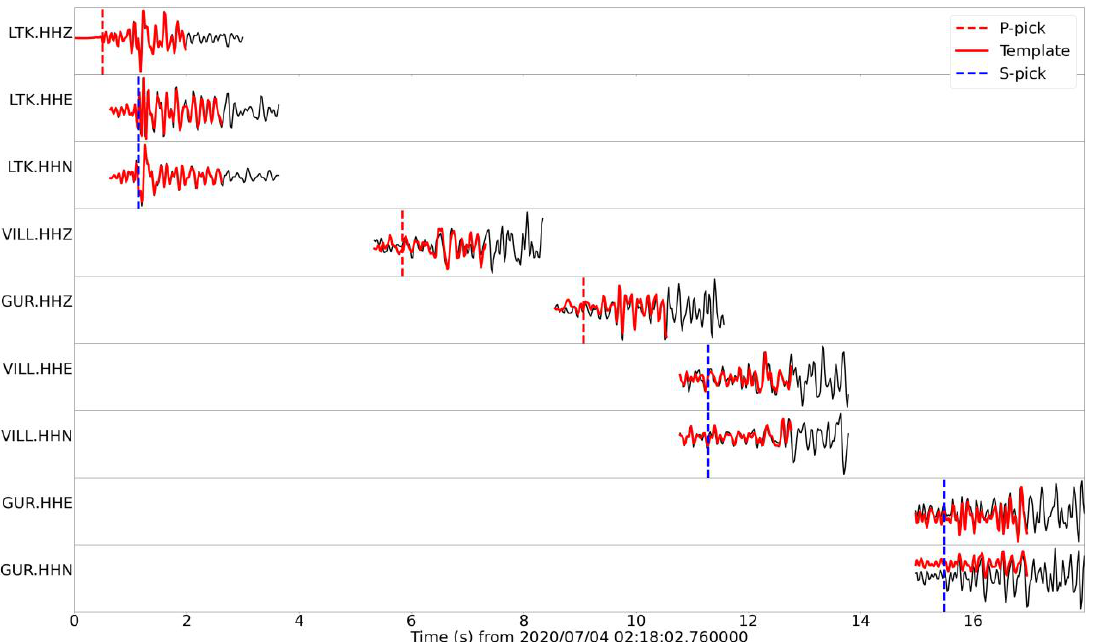
Figure 2. Example of the application of the EQcorrscan code for the detection of similar earthquakes with the template matching technique. The template waveforms are presented in red, while the part of the continuous record with detected signals is represented in black. The arrival times of P- and S-waves are depicted by vertical dashed red and blue lines, respectively. The different channels are divided by horizontal black lines and sorted by ascending arrival time of the respective seismic phase.